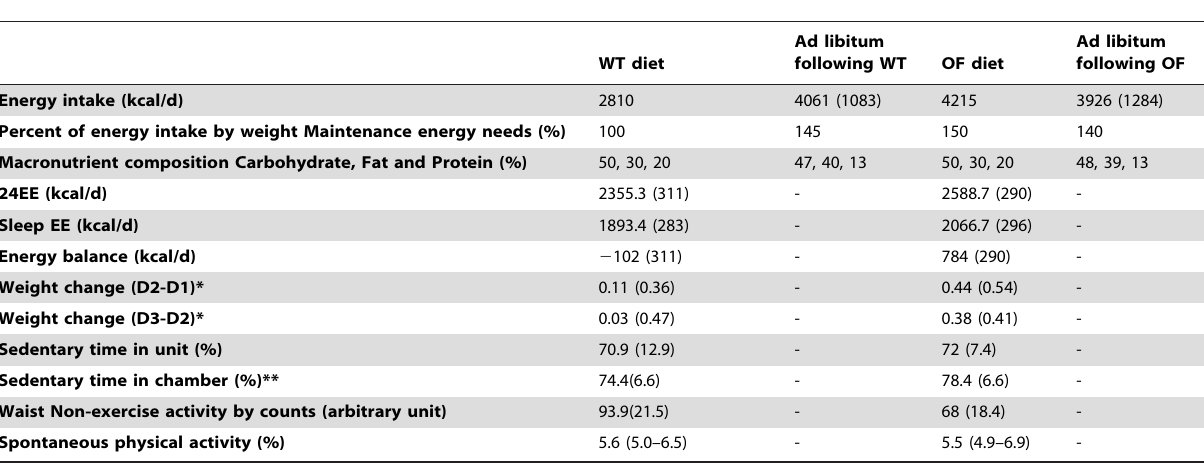
Table 2. Energy and Macronutrient Intake, Energy Expenditure and Non-exercise activity.